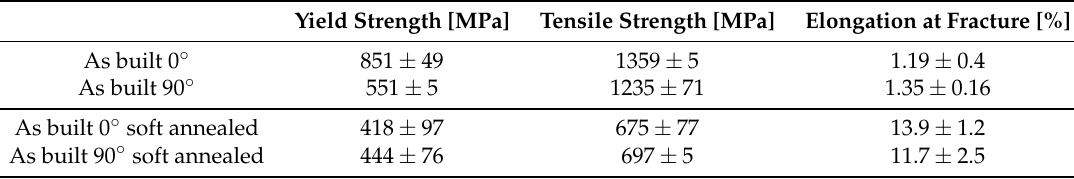
Table 3. Mechanical properties of additive manufactured H13 tool